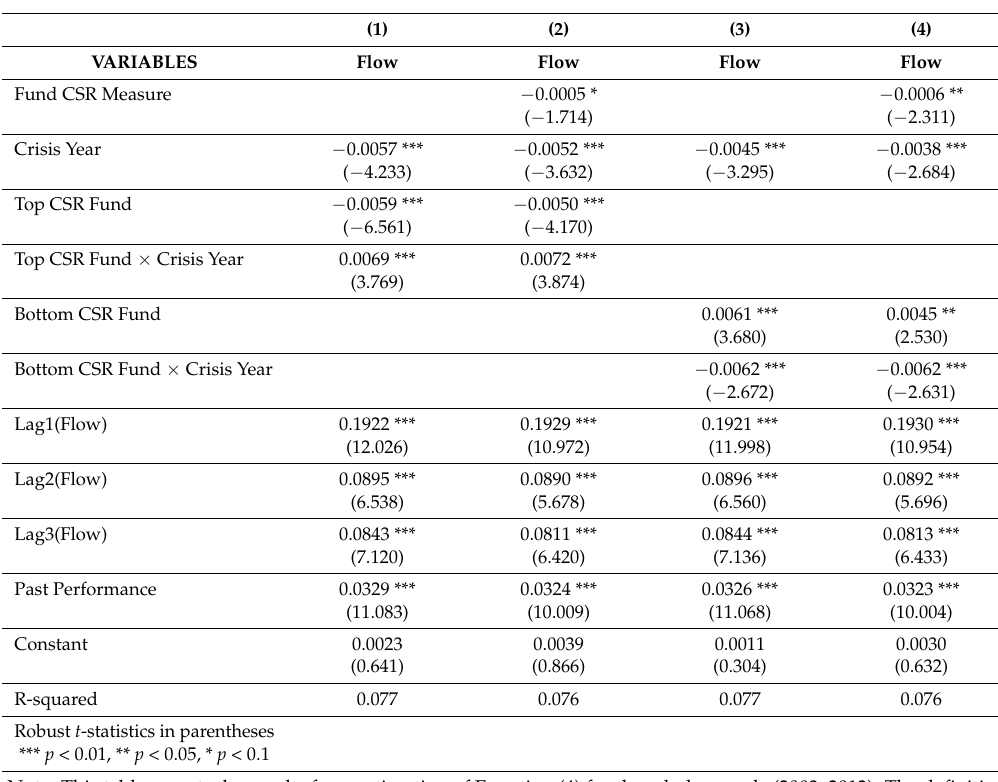
Table 10. CSR-funds and new investments: financial crisis versus non-crisis subsample analysis (investment style control variables